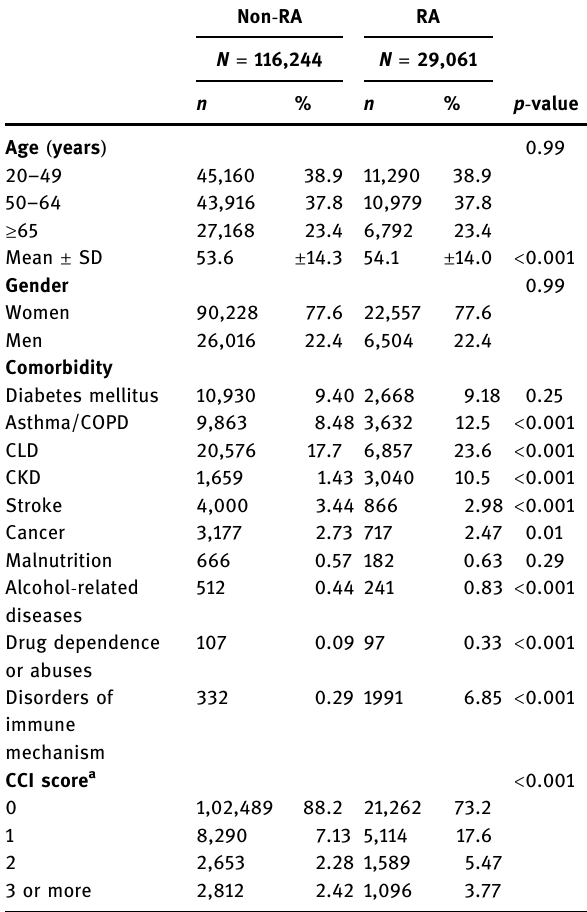
Table 1: Baseline characteristics of patients with RA and individuals without